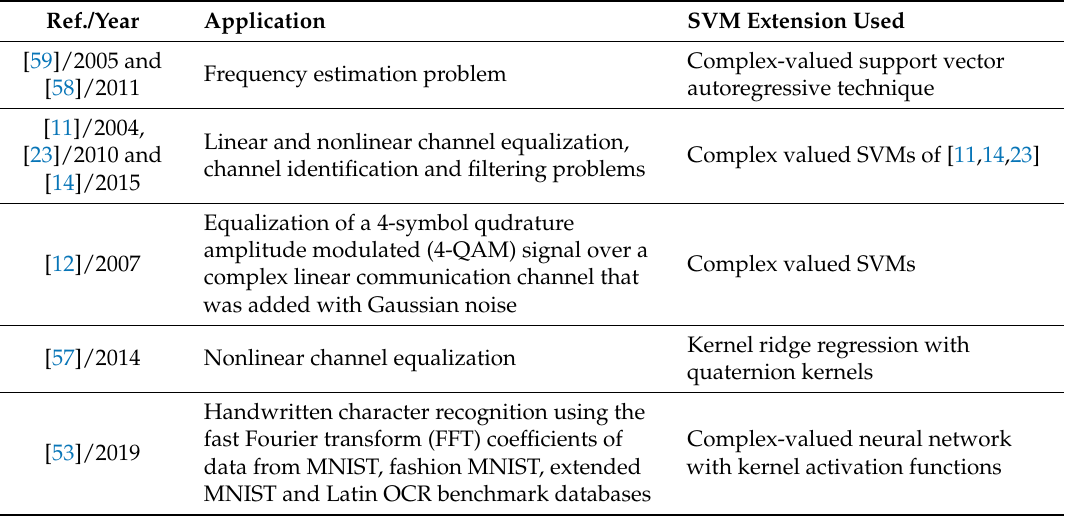
Table 5. Applications of complex and hypercomplex SVMs for frequency domain processing, linear and nonlinear filtering